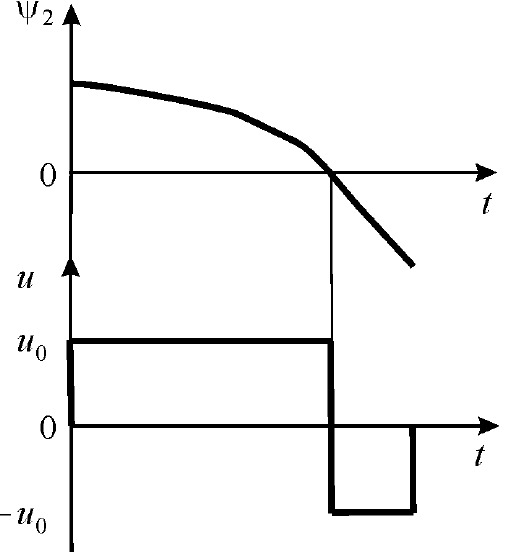
Figure 2. The control function in the optimal system.